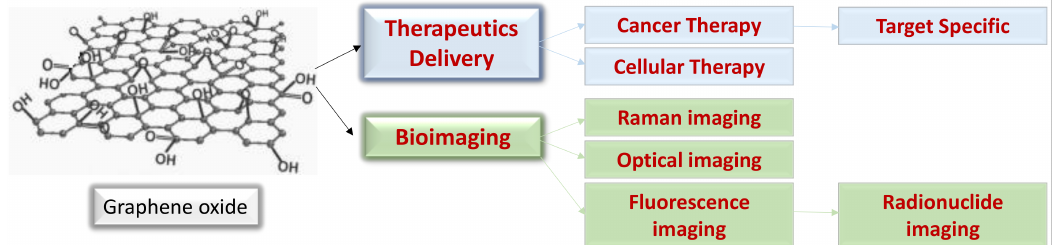
Figure 6. Various applications of graphene oxide in the biomedical arena. Adapted from